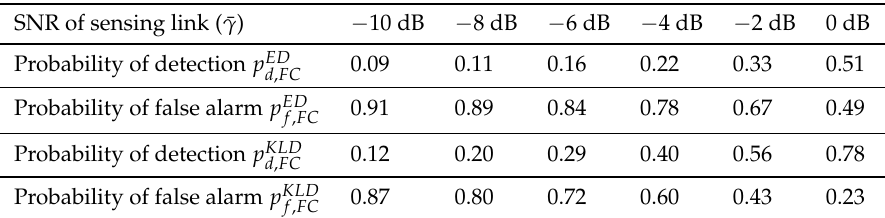
Table 3. Sensing performance at the FC of the proposed and conventional schemes under shadowing effects with N s = 30, ¯ γ = − 10 dB to 0 dB.